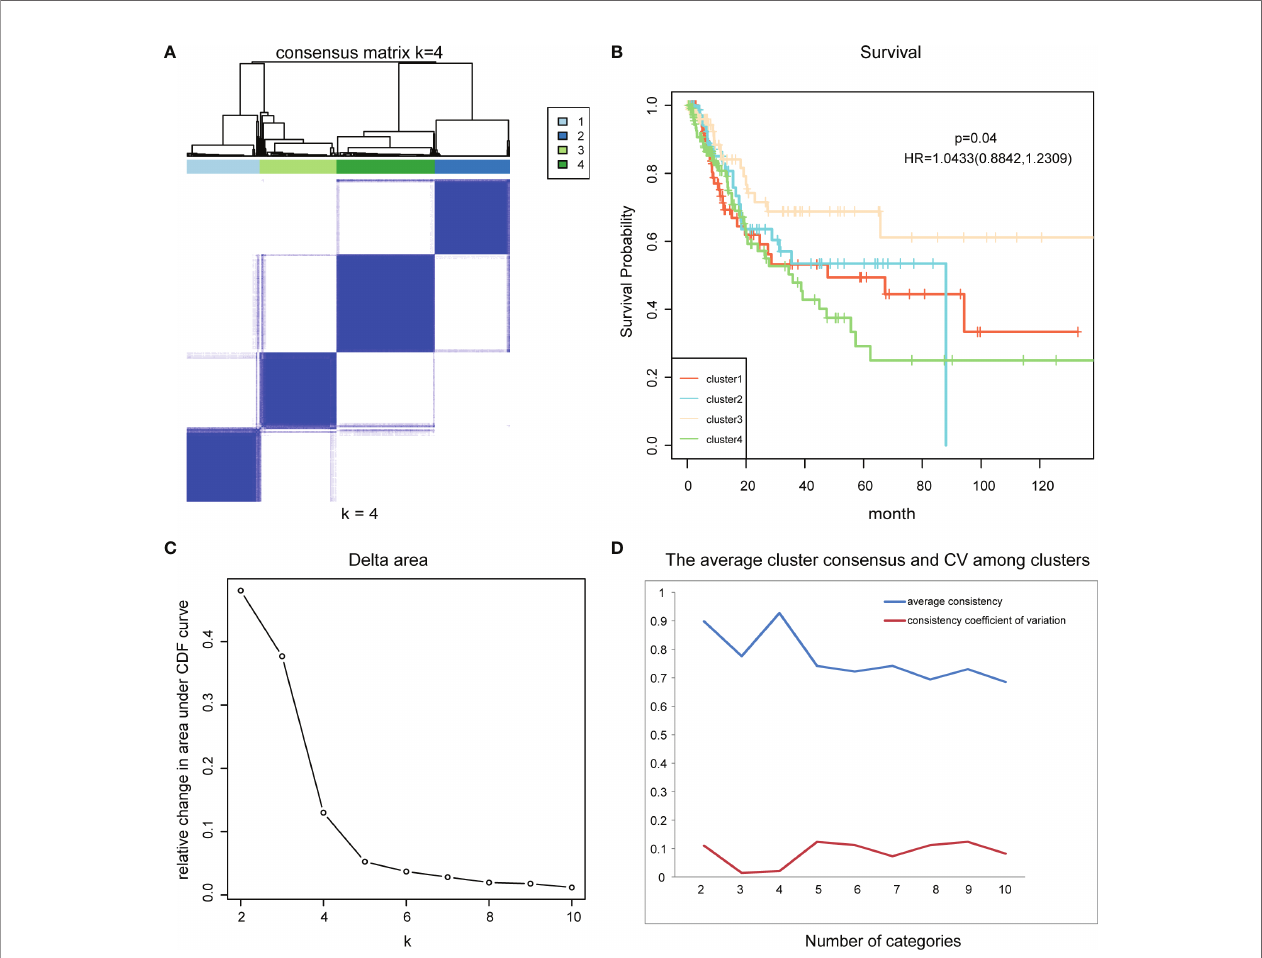
FIGURE 2 | Consensus clustering and survival analysis. (A) The color-coded heatmap corresponding to the consensus matrix for k = 4. (B) The survival curves of four DNA methylation subtypes of bladder cancer. (C) Delta area curve of consensus clustering. (D) The average cluster consensus and coef fi cient of variation among clusters for each category number